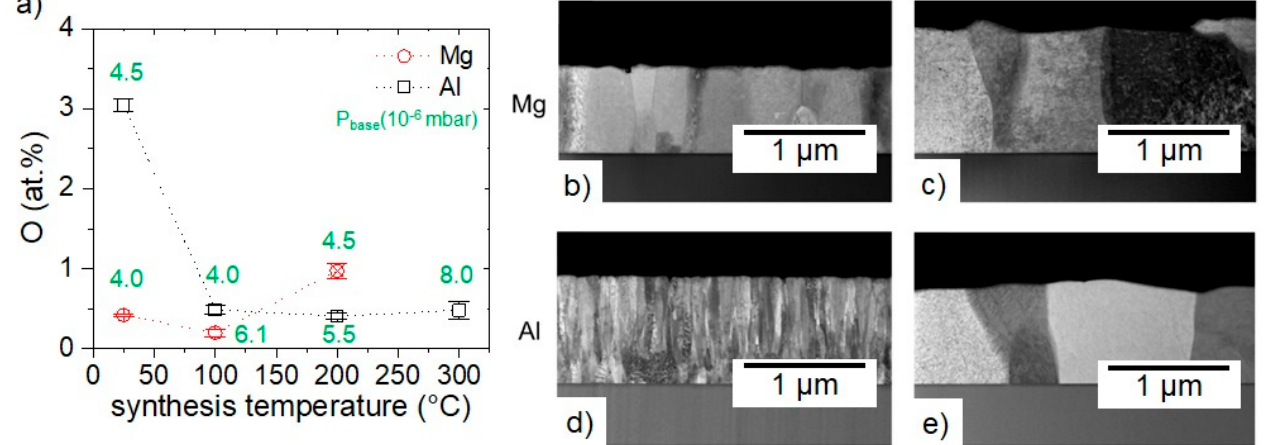
Figure 6. ( a ) O concentrations measured by EDX as a function of synthesis temperature for Mg and Al films in the as-deposited state (minimized air exposure time of ≤ 3 min). The red x marks the synthesis temperature where partial desorption of Mg is observed. The green values indicate the base pressure (P base ) at synthesis temperature before deposition. STEM images of Mg synthesized at ( b ) RT and ( c ) 100 °C; Al synthesized at ( d ) RT and ( e ) 200 °C. Mg films synthesized at RT and at 100 °C show similar O concentrations of 0.4 ± 0.1, 0.2 ± 0.1, respectively whereas the film deposited at 200 °C exhibits an O concentration of